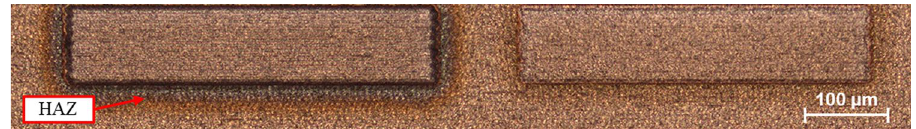
Figure 12. Comparison of laser processing of copper without gas processing (left) and with gas processing